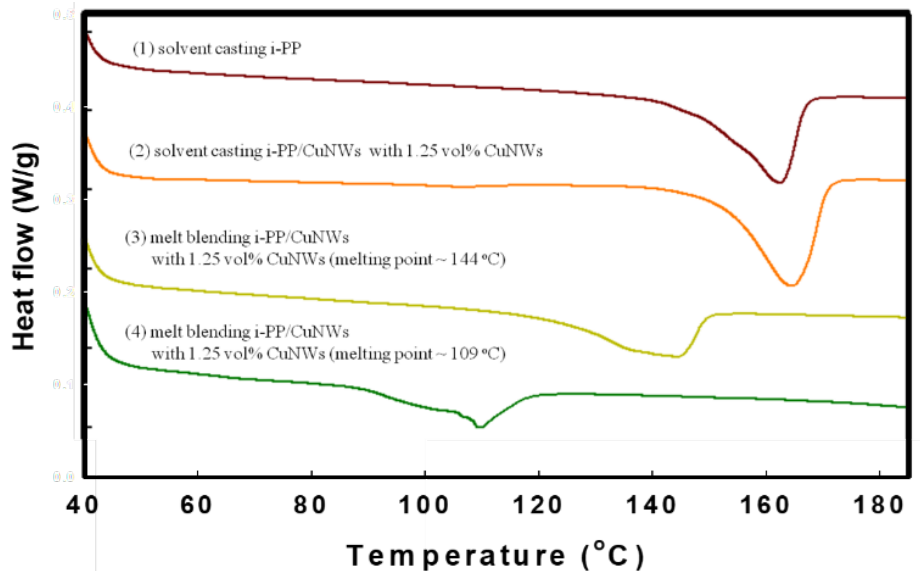
Figure 8. The DSC thermographs for (1) solution casting i-PP and (2) solution blending i-PP/CuNWs (1.25 vol%) composites, (3) 1 min melt blending time, and (4) 5 min melt blending time.